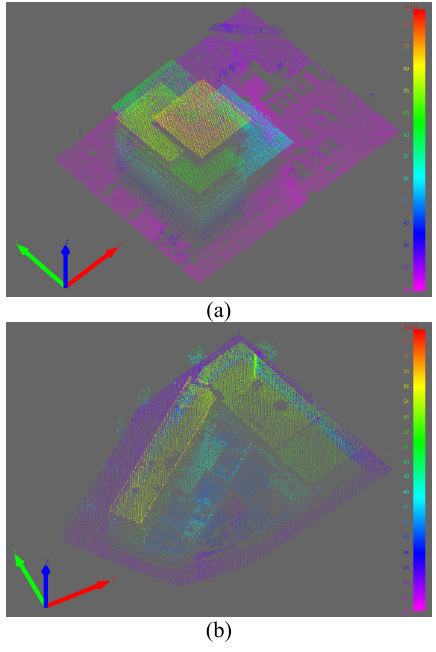
Figure 5. Test datasets for (a) Case I and (b) Case II (Unit: